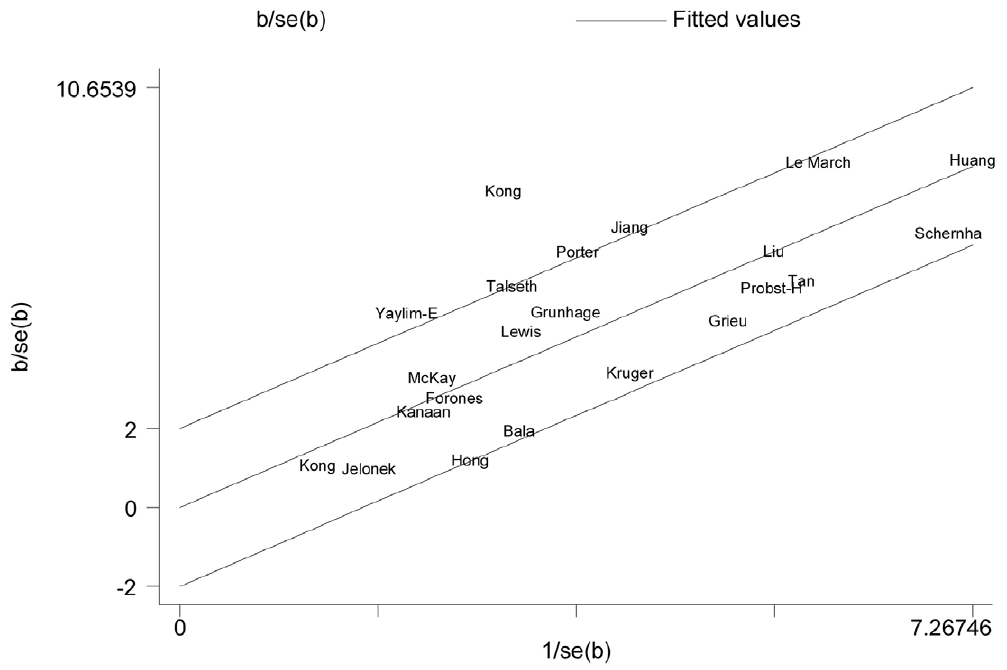
Figure 2. Galbraith plot [ 12 ] analysis of the amount of heterogeneity from all the included studies (AA vs. GG). The y-axis shows the ratio of the log OR to its standard error (SE), and the x-axis shows the reciprocal of the SE. Each study is represented by the name of the first author. A regression line runs centrally through the name. At a 2 standard deviation distance parallel to the regression line, the 2 lines create an interval. Studies lacking in heterogeneity would lie within the 95% confidence interval (positioned 2 units above and below the central regression